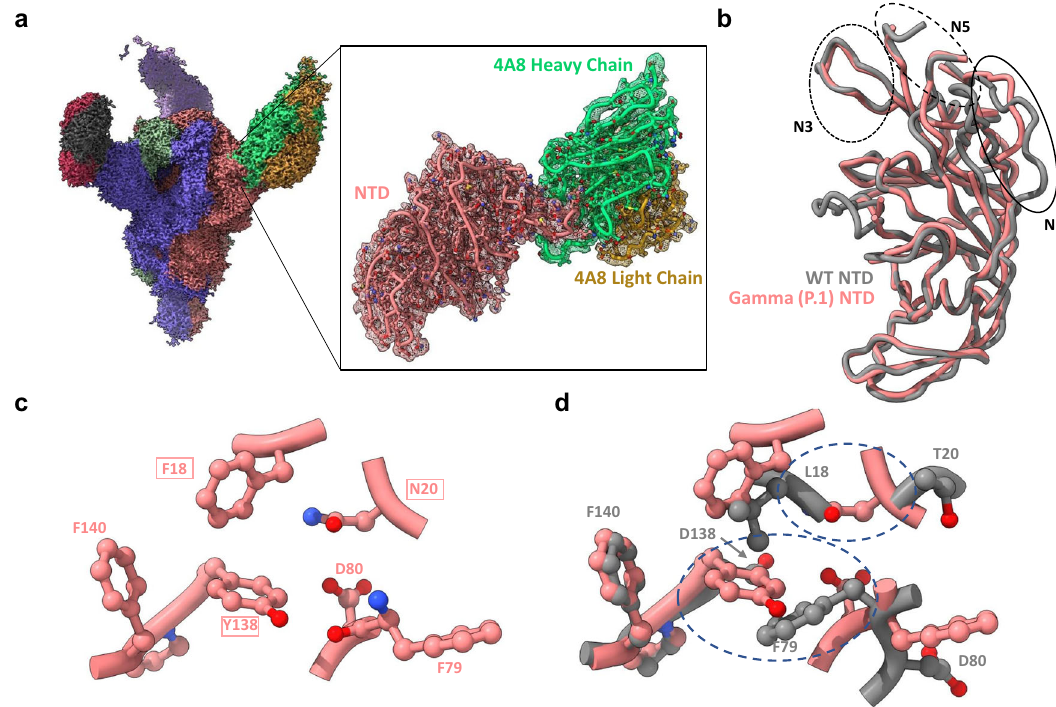
Fig. 5 | Structure of the Gamma variant NTD reveals rearrangement of the N1 loop. a Global cryo-EMdensity map of the Gamma variant S protein bound to 4A8 at 2.59Å (left), and a focus-re fi ned map and model for the Gamma NTD-4A8 complex at 2.66Å (right). b Superposition of 4A8-bound Gamma and wild-type NTD models showing N1 loop rearrangement. The three loops (N1, N3, N5) com- prising the “ NTD neutralization supersite ” are indicated with circles. c Positioning